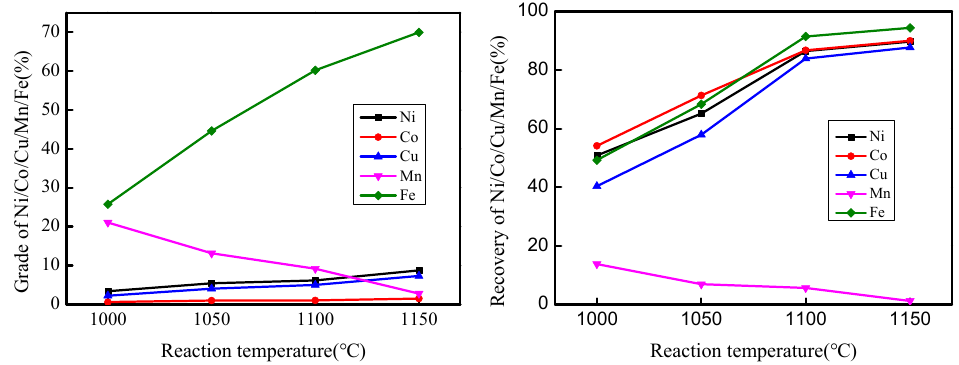
Figure 11. Effect of reaction temperature on the concentration of valuable metals.